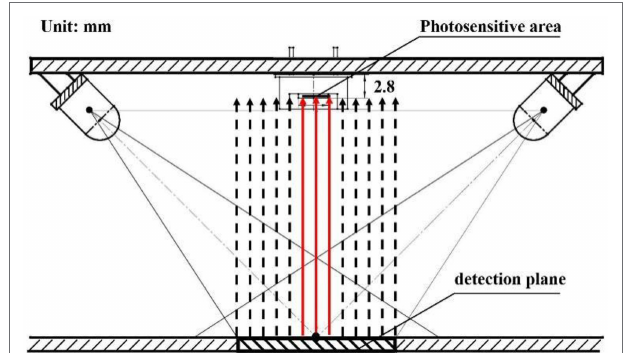
FIGURE 7 | Direct spectrum acquisition of diffuse reflection tube.